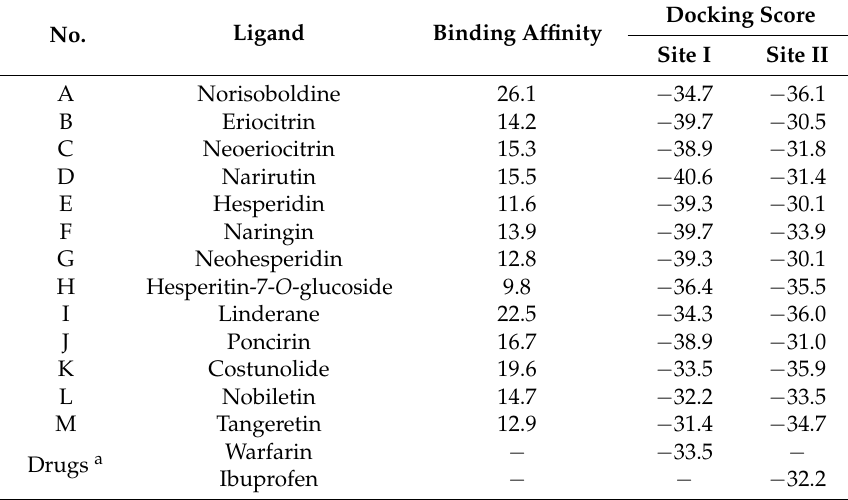
Table 2. Binding affinity (%) and docking score (kj/mol) of the ligands in Simo decoction (SMD) with human serum albumin